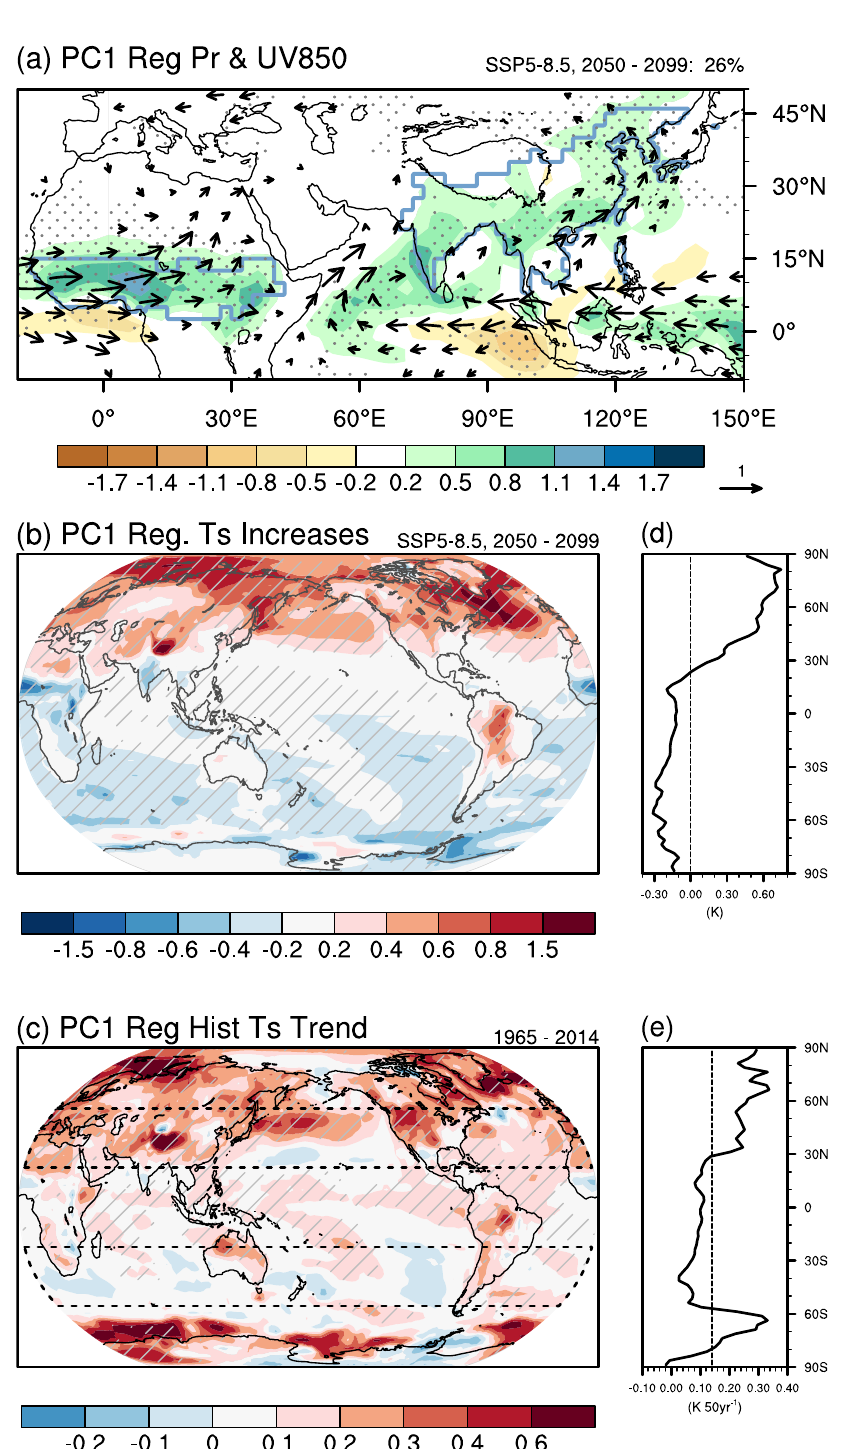
Fig. 2 Dominant pattern of projected uncertainty and related historical pattern. a The projected precipitation (shading, mm day − 1 ) and wind at 850 hPa (UV850; vector, m s − 1 ) across 30 CMIP6 models under high-emission scenario (SSP5-8.5) regresses onto the inter-model normalized leading principal components (PC1). The PC1 are derived from the inter-model empirical orthogonal function (EOF) analysis of projected precipitation change under SSP5- 8.5 in 2050 – 2099 relative to 1965 – 2014 (see Methods). The percentage on the top-right corner is explained inter-model variance. b the future increase of surface temperature in 2050~2099 and c the trend of surface temperature (K) in 1965 – 2014 across models regresses onto the inter-model normalized PC1. Panels d and e are the zonal mean of the regression coef fi cient, and the thin dash vertical lines are the global area mean of the regression coef fi cient. The stippling, black vectors and hatching represent the regression exceeds 90% con fi dence level under Student ’ s t test. Black dash boxes in c are used to de fi ne the pattern indices to constrain the PC1 (see